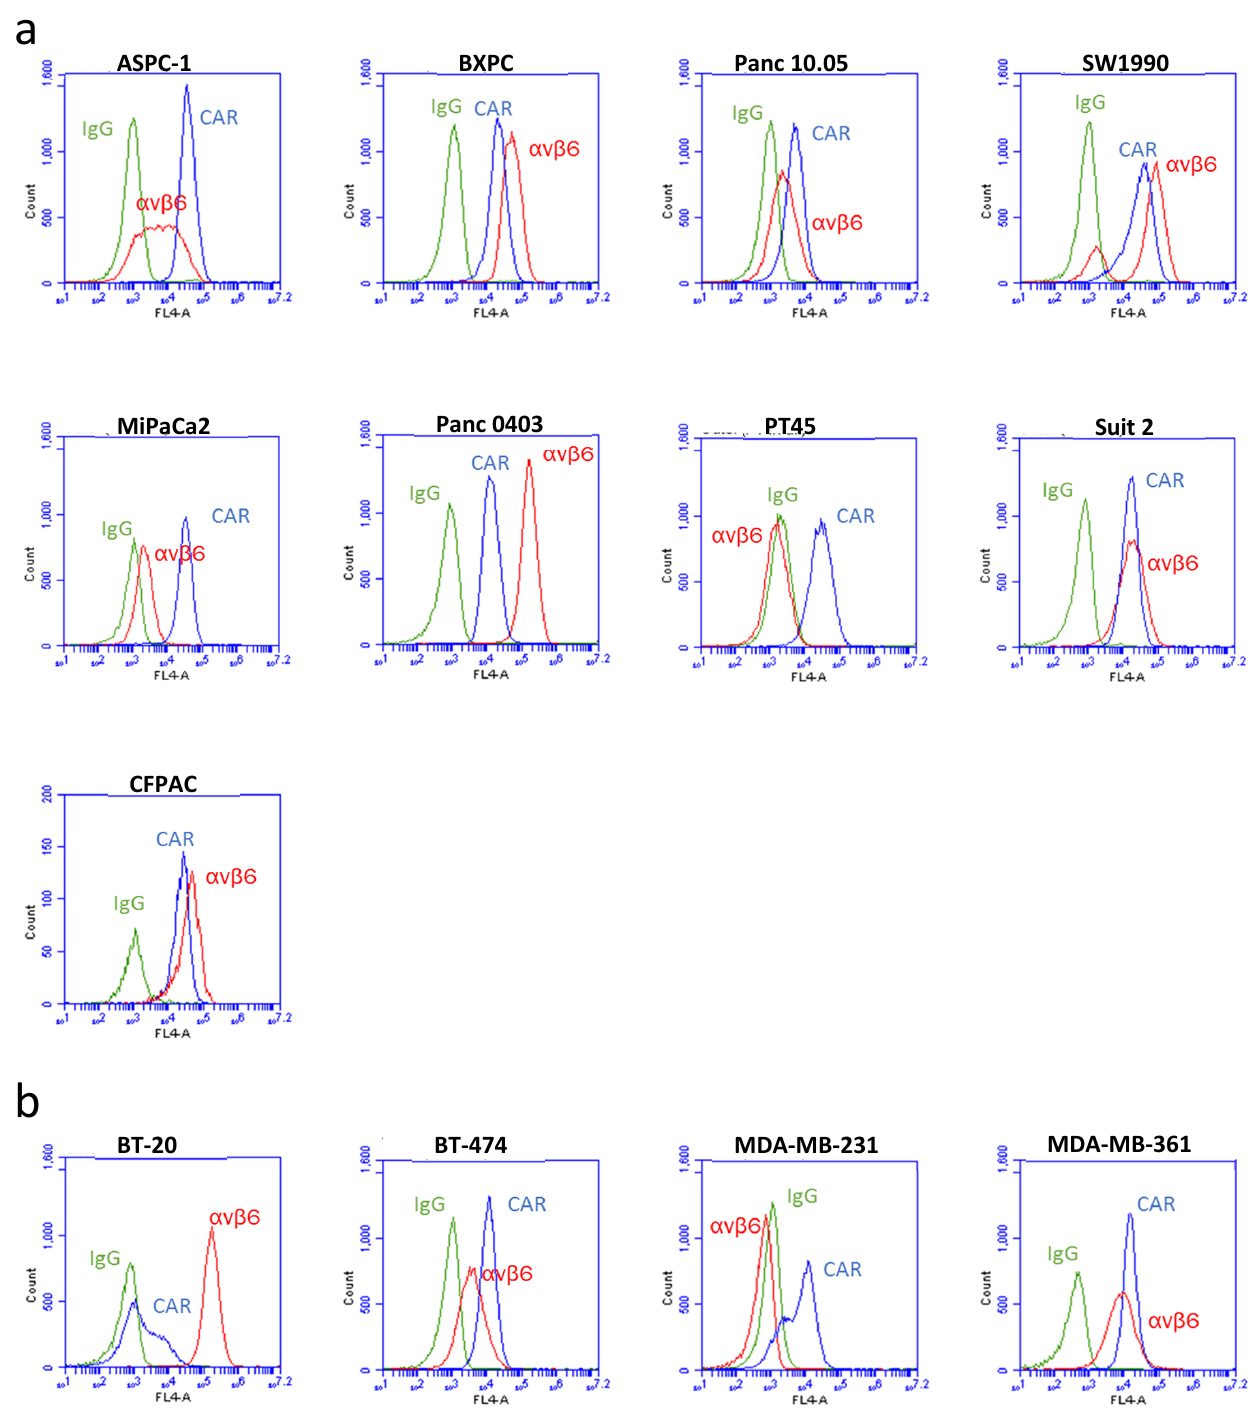
Figure 1. Expression of αvβ6 integrin and CAR were measured by flow cytometry. Panels of pancreatic cell lines ( a ) and breast cancer cell lines ( b ) were stained for surface expression of αvβ6 integrin (red), CAR (blue) and IgG control (green). Cells were gated to exclude dead cells, and a minimum of 10,000 events were recorded.